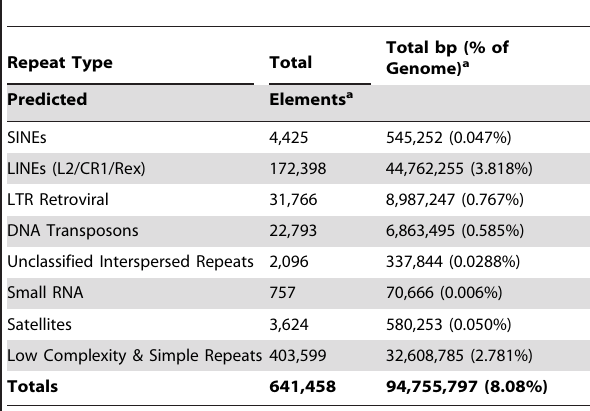
Table 3. Major classes of repetitive content predicted by RepeatMasker within the bobwhite NB1.1 scaffolded de novo